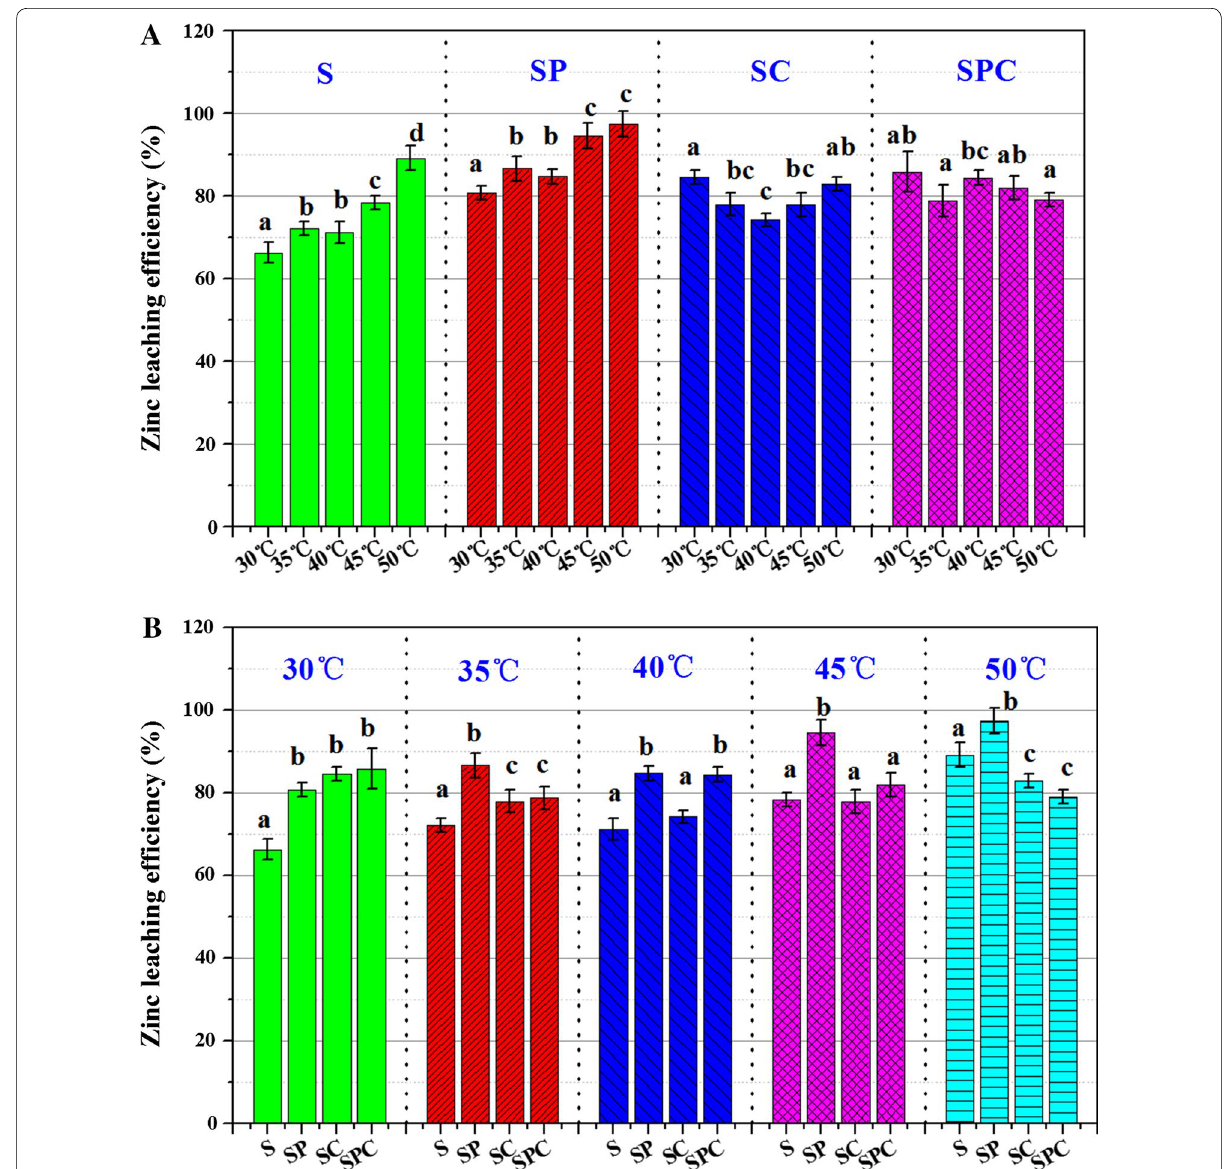
Fig. 1 Zinc leaching efficiency on day 30 under different temperature ( A ) and mineral composition ( B